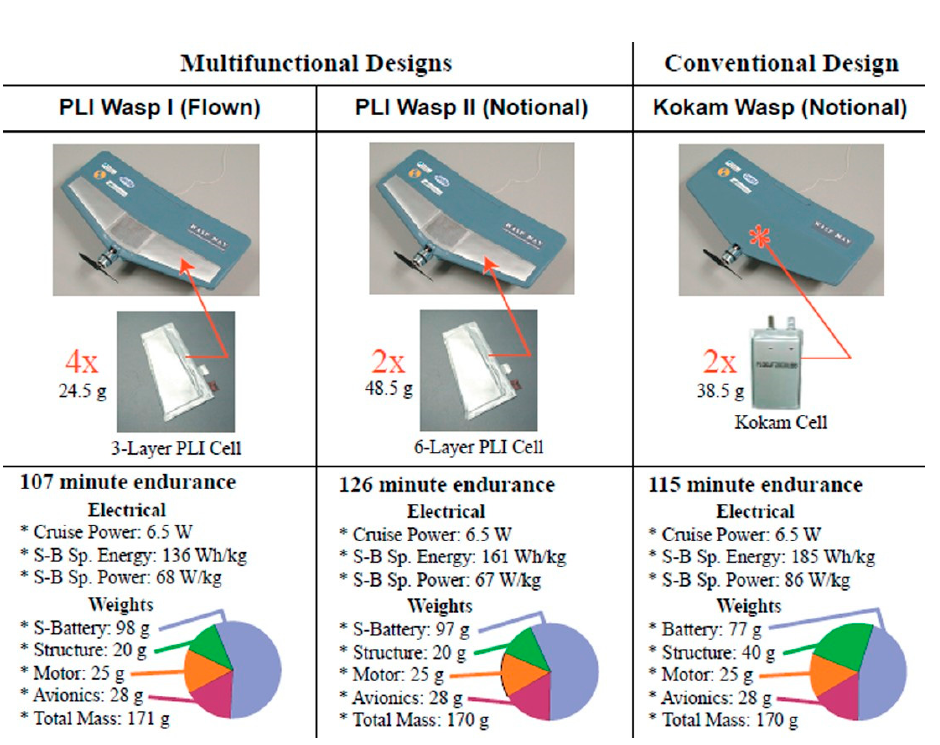
Figure 3. Unmanned aerial vehicles (UAVs) improved performance via multifunctional structure [23].